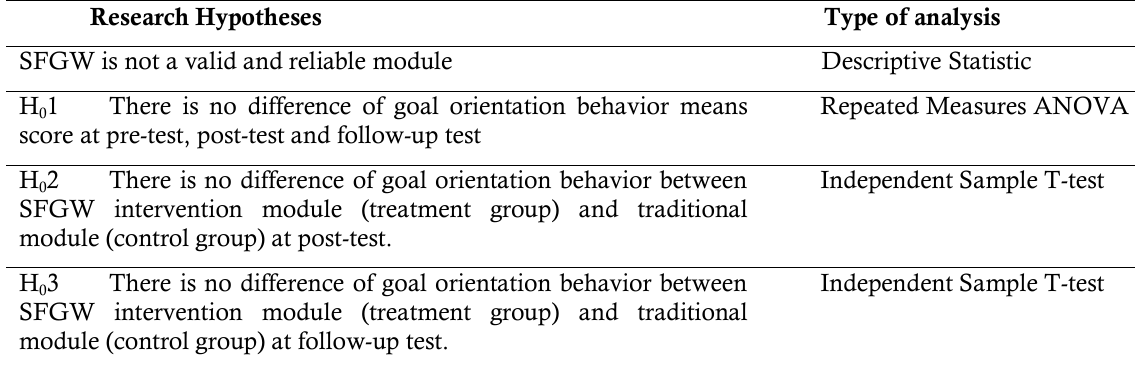
Table 1. Statistical Analysis based on Research Questions/ Hypotheses Research Hypotheses